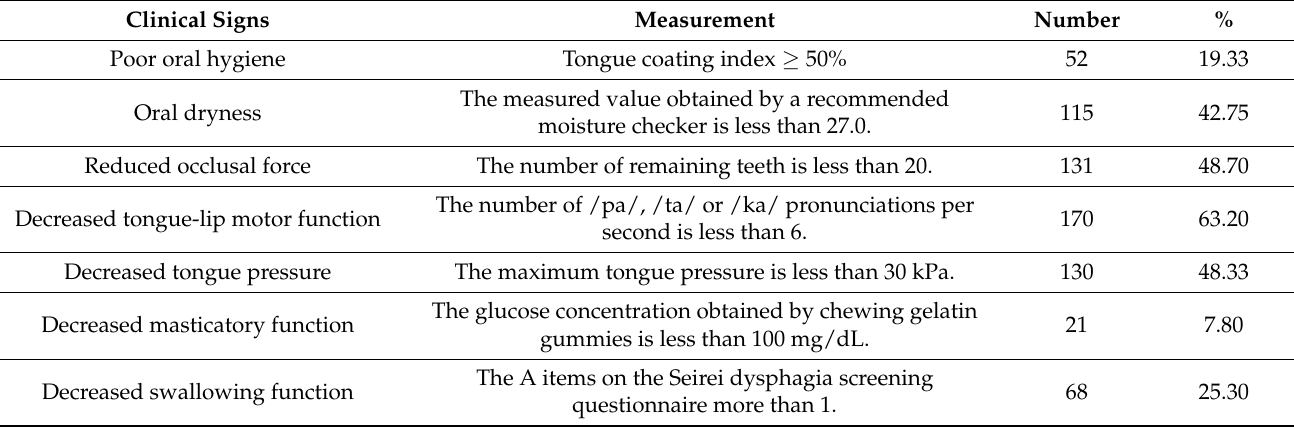
Table 1. Items for oral function assessment and the number and percentage of patients with oral